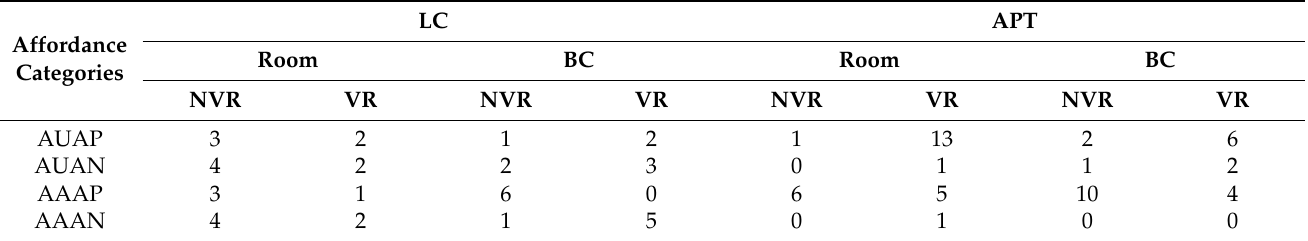
Table 14. Number of affordances perceived on both design options in each LC and APT projects.